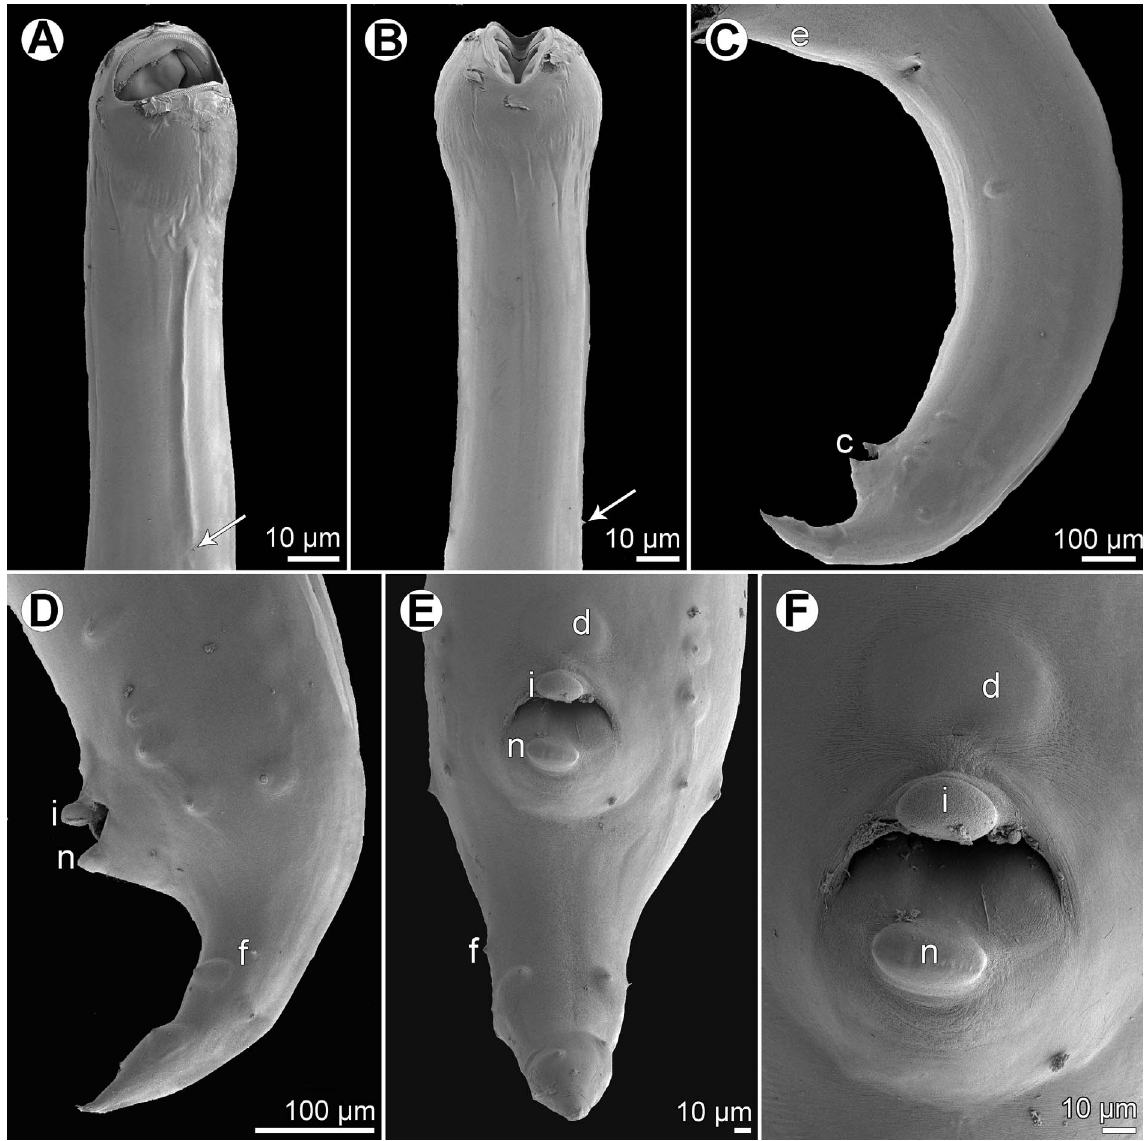
Figure 3. Cucullanus austropacificus n. sp., scanning electron micrographs. (A, B) Anterior end of body, sublateral and dorsoventral views, respectively (arrows indicate deirids; note presence of cervical alae); (C) posterior end of male, lateral view; (D, E) tail of male, lateral and ventral views, respectively; (F) region of cloaca, ventral view (higher magnification). (c) cloaca; (d) median precloacal papilla-like formation; (e) ventral sucker; (f) phasmid; (i) median outgrowth of anterior cloacal lip; (n) median outgrowth of posterior cloacal